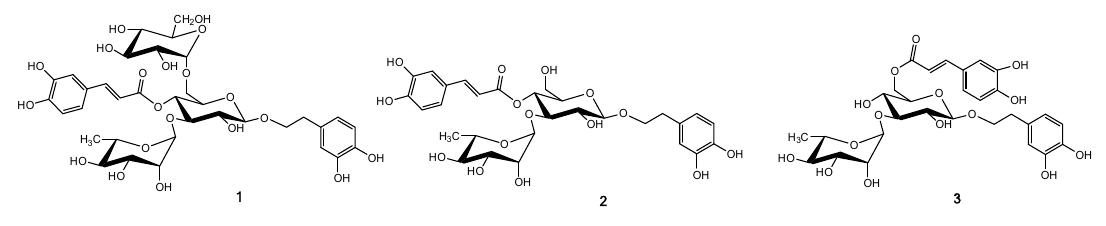
Figure 1. Structures of 1 , 2 , and 3 isolated from C. tubulosa .